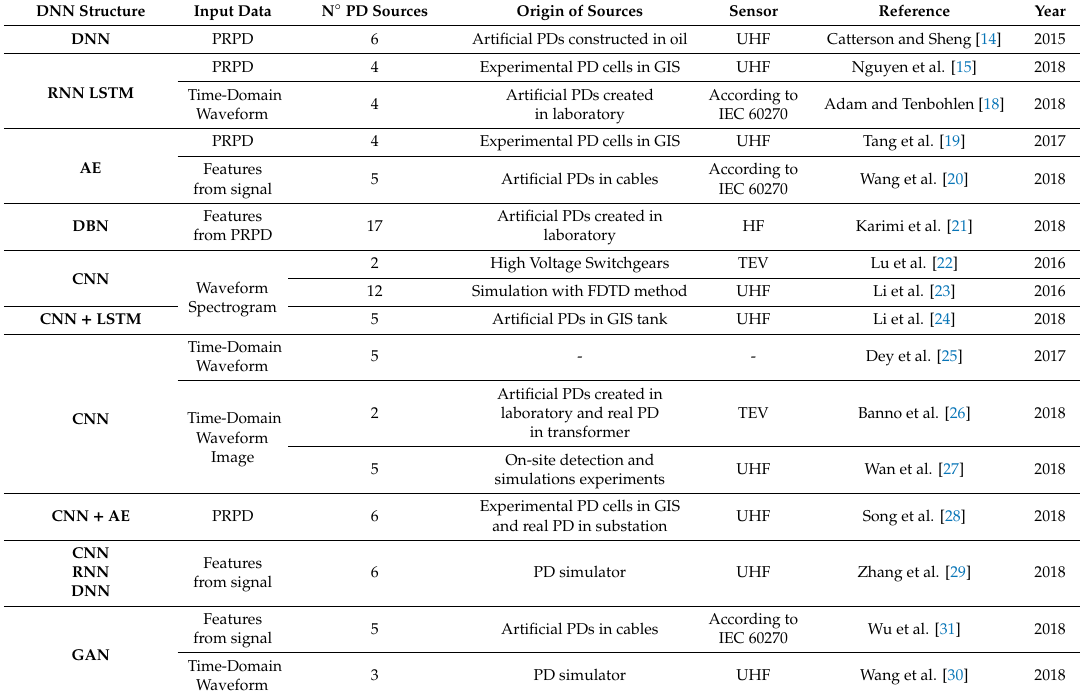
Table 4. Summary of DNN techniques that have been used for PD